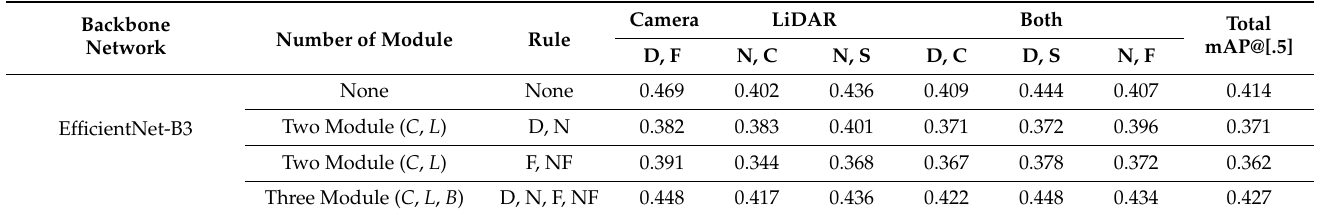
Table 5. Object detection performance according to the division of dominance. C is the camera dominance module, L is the LiDAR dominance module, B is the ‘both’ dominance module. Rule means distinguish the influence of each sensor. D: Daytime, N: Nighttime, F: Fog, NF: Not fog, C: Clear, S: